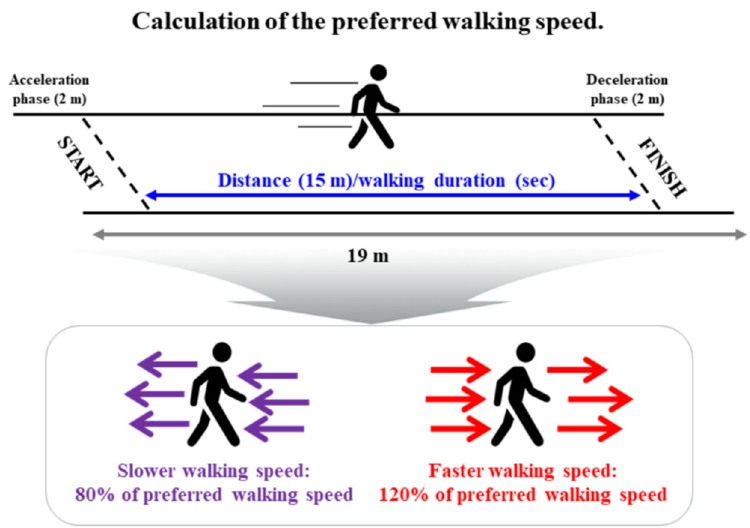
Figure 2. Chart showing the gait test: three-speed conditions based on the preferred walking speed (slower walking speed (80% of preferred walking speed) and faster walking speed (120% of pre- ferred walking